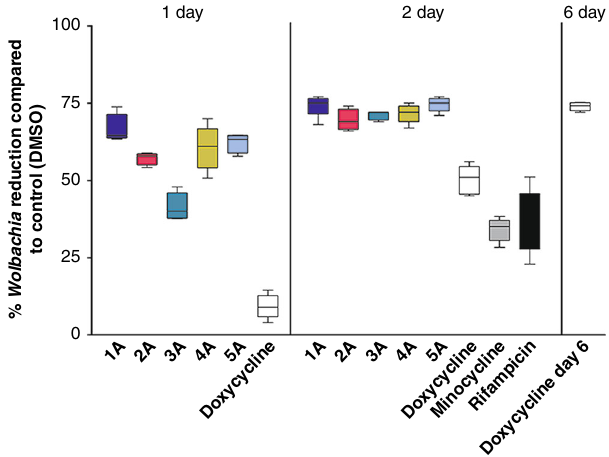
Fig. 5 Anti- Wolbachia time-kill analysis. Representatives from the top fi ve clusters (1A – 5A), as well as established anti- Wolbachia antibacterials (doxycycline (white), minocycline (grey), rifampicin (black)) were assessed after exposure for 1 day and 2 days before washing and further incubation until the standard 6-day read out. wsp : gst ratio was normalised to the DMSO vehicle control resulting in a read out of mean percentage reduction from control. Doxycycline day 6 treatment represents the result for exposure to doxycycline at 5 µ M for a full 6 days (no wash). The box extends from the 25th to the 75th percentile with the median presented by the central line. The whiskers are set at the minimum and maximum therefore indicating the range from fi ve replicates. The cluster number is indicated by colour: cluster 1 (dark blue), 2 (magenta), 3 (teal), 4 (dark gold), and 5 (light